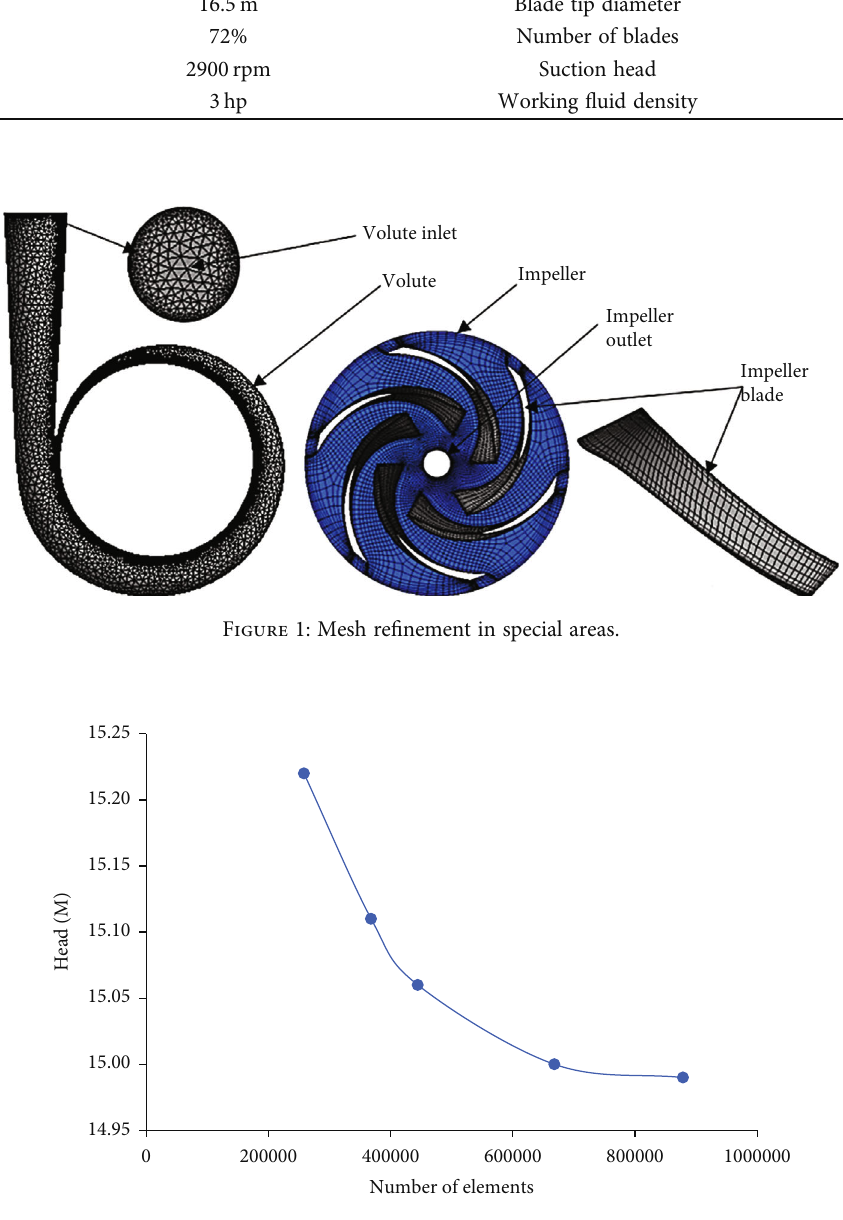
Figure 2: E ff ects of mesh number on the numerical